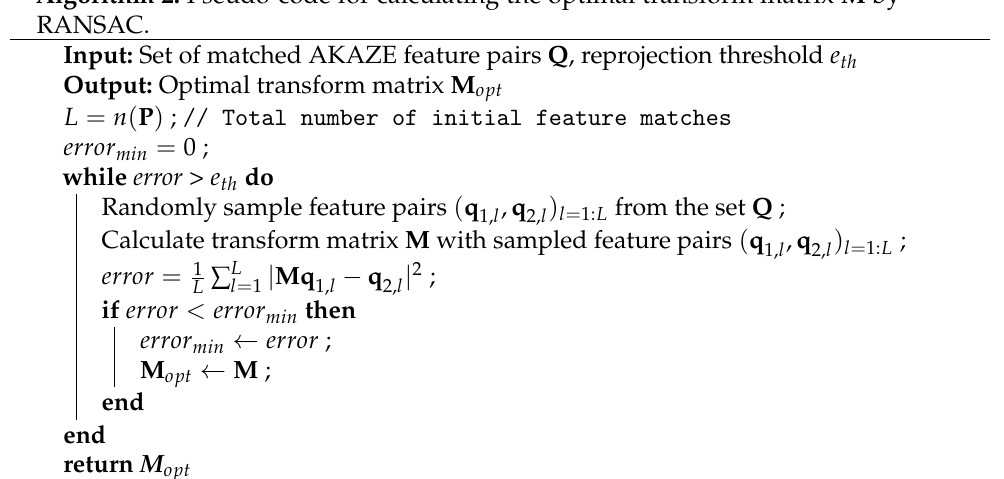
Figure 8. Image alignment between the matched image from the database and its corresponding query image. Images may be taken in slightly different viewpoints ( a ) or pose differences of some objects in the image ( b ). These are considered as different images. On the other hand, the image processed from matched image ( c ) needs to be recognized as the same image. The overlapped region is marked in green. We additionally plot the structure similarity and boxes centered at a local minimum. Note that mean value for ( a – c ) are 0.33, 0.96, and 0.96, respectively. Algorithm 2: Pseudo-code for calculating the optimal transform matrix M by